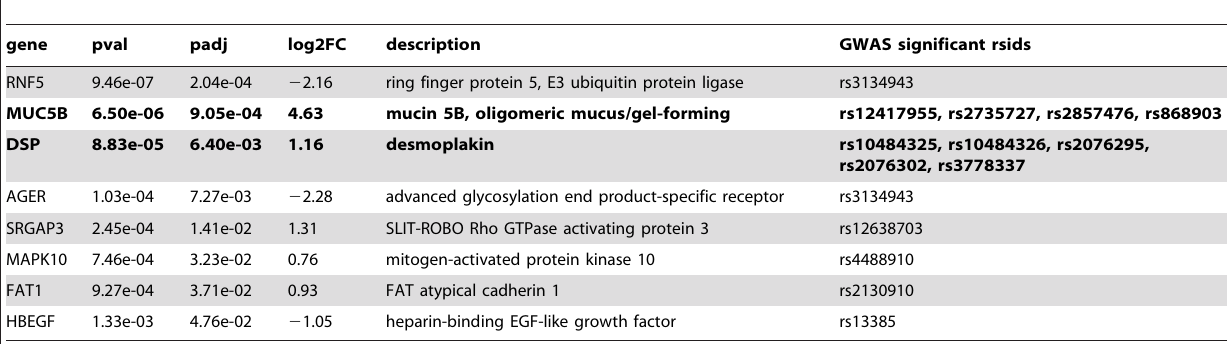
Table 2. Genes associated with GWAS [5] validation SNPs which are differentially expressed in RNA-Seq data at 5% FDR.